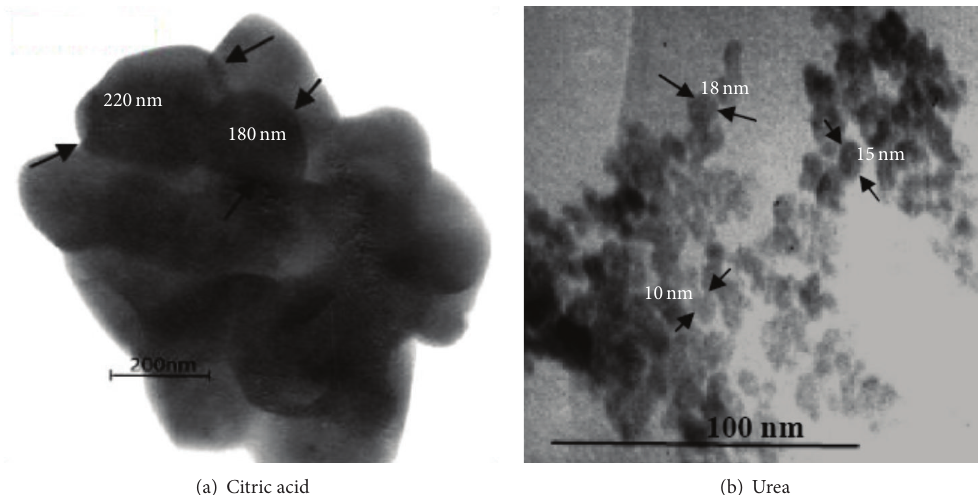
Figure 5: TEM images of Al 2 O 3 nanoparticles prepared with complexing agent. (a) Citric acid and (b) urea calcined at 1250 ∘ C for 1 hour.